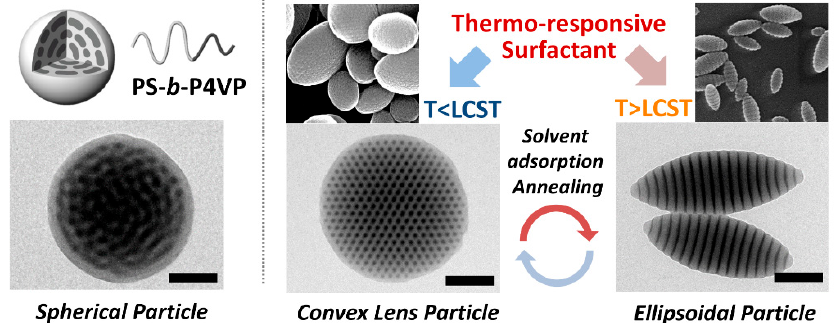
Figure 4. Temperature-driven transformation of the shape and morphology of PS- b -P4VP particles using temperature-responsive poly(N-isopropylacrylamide) (PNIPAM) surfactants (reprinted with permission from [62], Copyright 2017, Wiley-VCH).